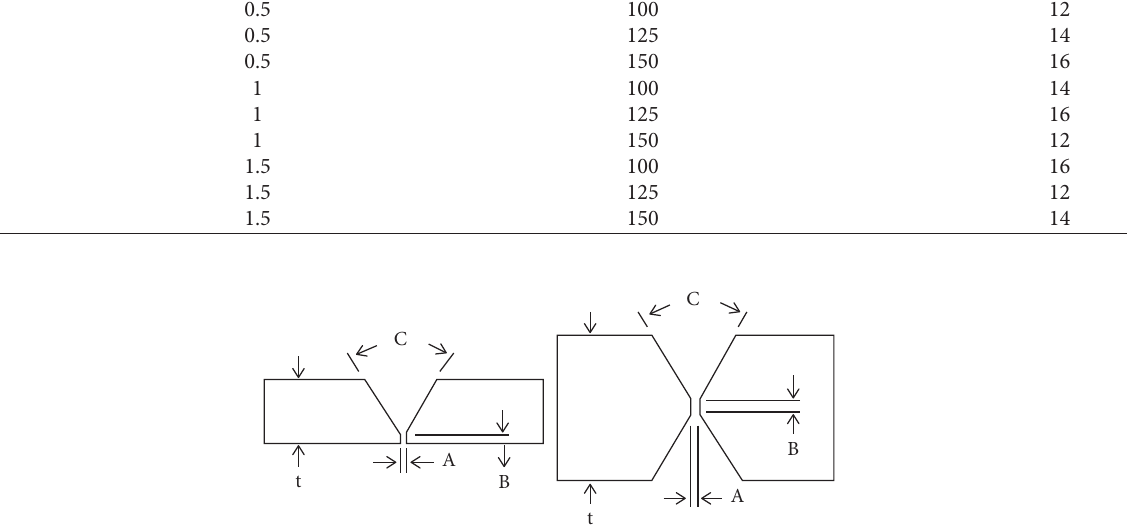
Figure 1: (A-root gap, B-land, C-groove angle, t-material thickness). Table 2: Primary variables of low carbon steel (material properties).